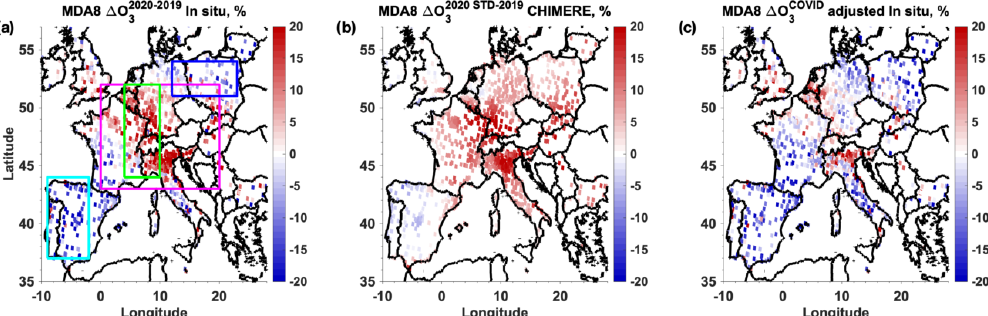
Figure 3. Relative changes (in %) in maximum daily average during 8h (MDA8) of surface ozone concentrations between 2020 and 2019, during the period 1–30 April (a) measured by in situ sensors, (b) associated with meteorological conditions derived from the difference between CHIMERE simulations in 2020 using STD emissions and 2019, and (c) related with the pandemic lockdown in 2020 measured by in situ sensors and adjusted for subtracting the effects of meteorological conditions using Eq. (1). Percentages are calculated with respect to averages for the corresponding period in 2019. Rectangles in panel (a) indicate the target regions indicated in the text and Tables 4 to